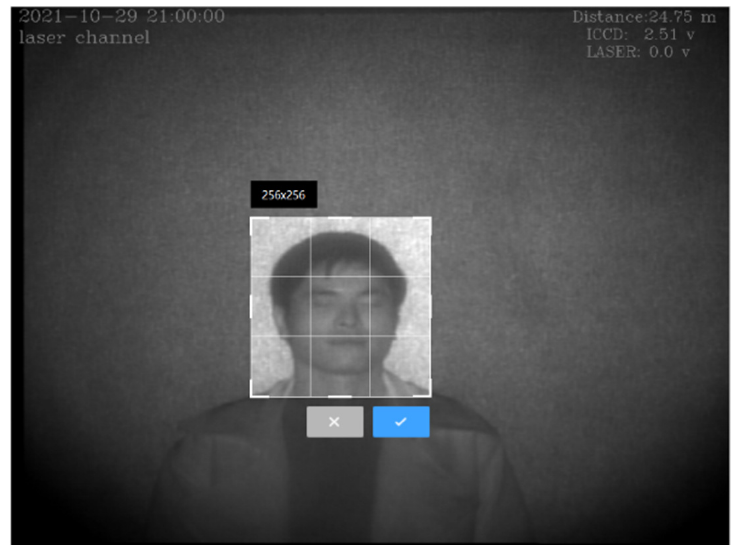
Figure 4. The size of the laser head in the entire image.